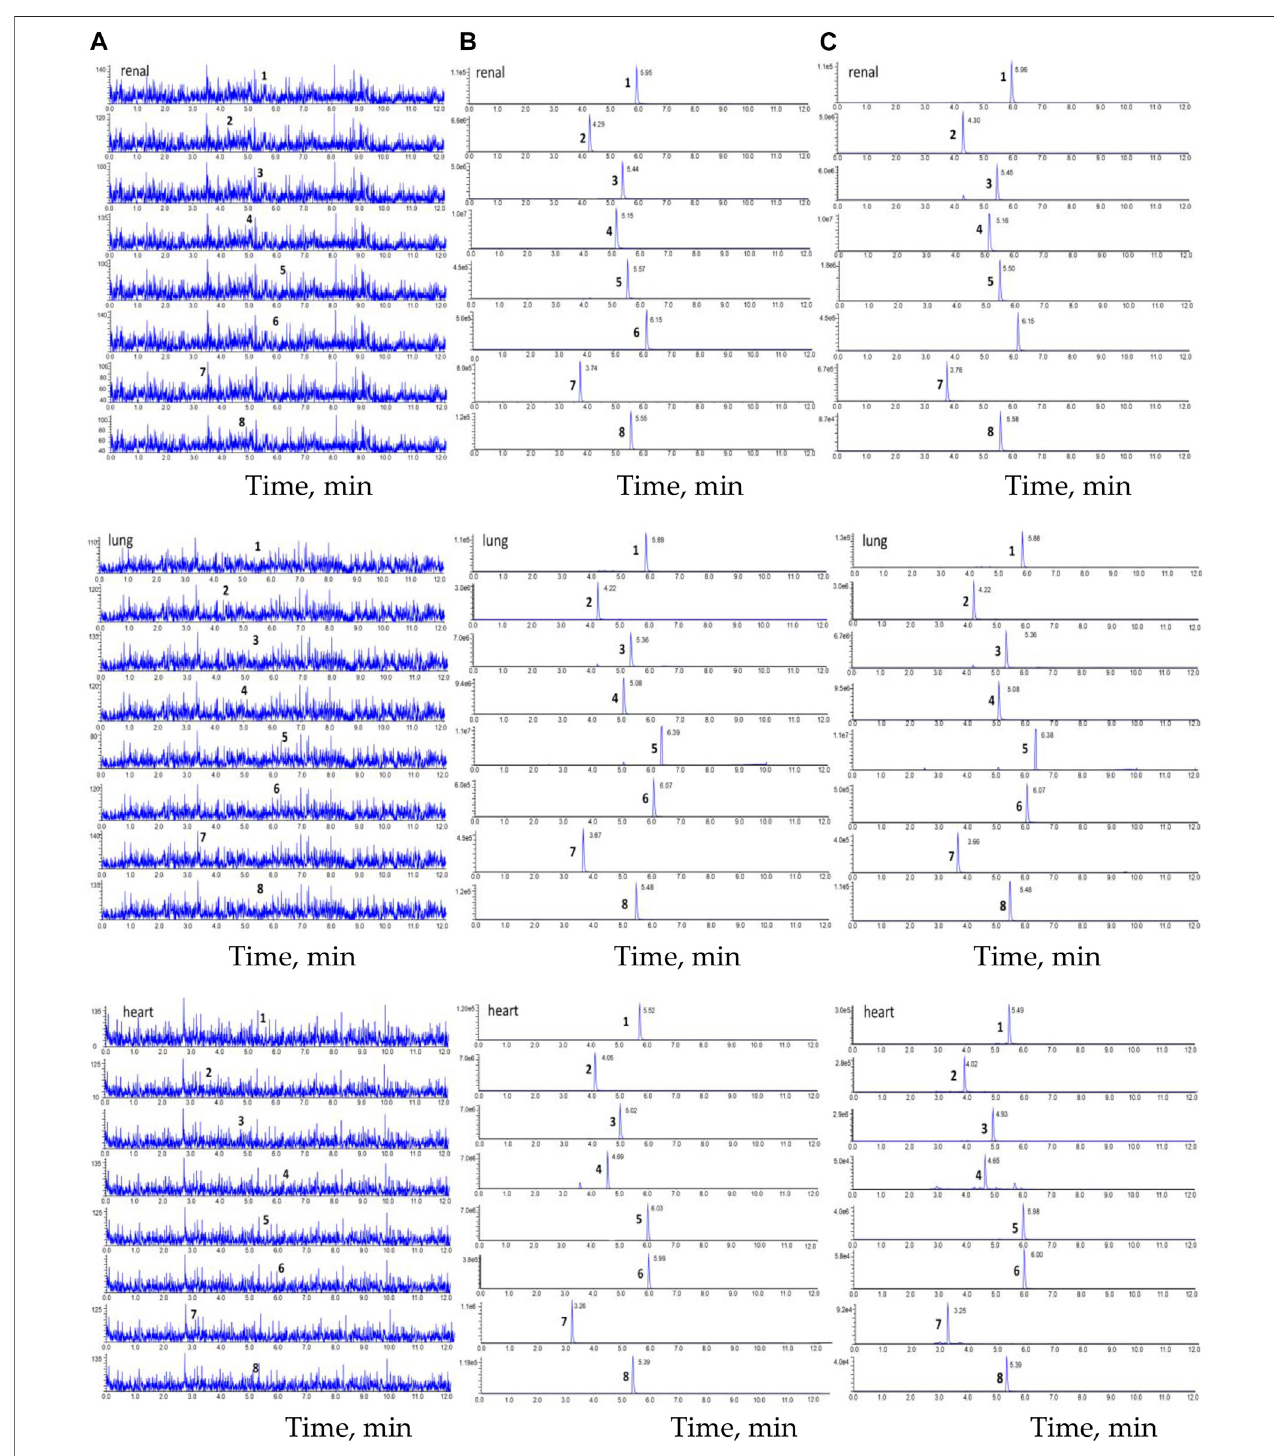
FIGURE 9 | The chromatogram of HPLC-MS/MS. (A) blank tissue homogenate sample; (B) blank tissue homogenate sample spiked with six compounds and IS; (C) The tissue homogenate sample obtained at 30 min after oral HQD. (1. astragaloside IV, 2. calycosin-7-O- β -D-glucoside, 3. calycosin-glucuronide, 4. ononin, 5. formononetin, 6. glycyrrhetinic acid, 7. puerarin, and 8. digoxin).